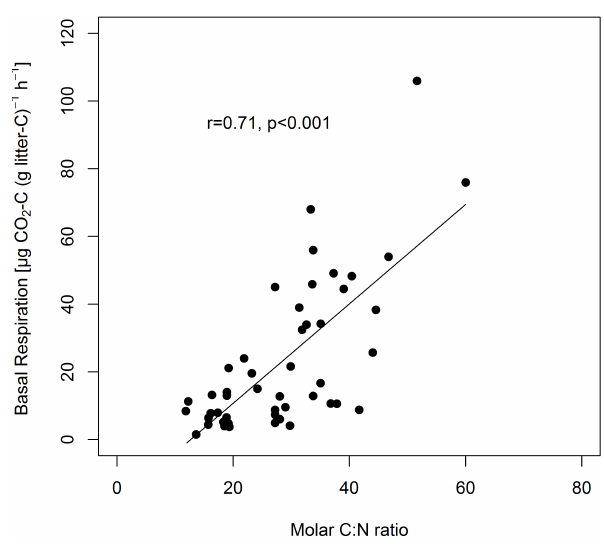
Figure 3. Correlation between the basal respiration rate and the mo- lar carbon-to-nitrogen ratio (C:N) of the soil litter